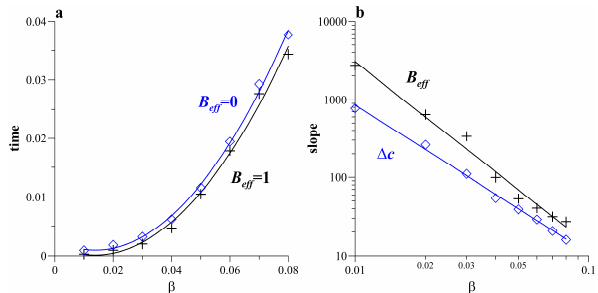
Figure 4. (a) Occurrence time of the two most characteristic events: B eff = 1 (onset of mixing) and B eff = 0 (end of mixing) as well as (b) slope of the decrease of the concentration difference and the ef- fective buoyancy ratio during the erosion/dilution phase as a func- tion of β